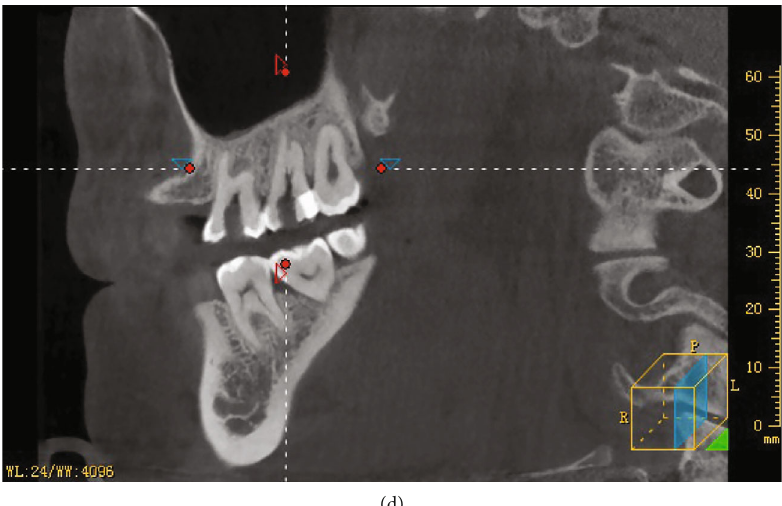
Figure 3: Cone-beam computed tomography images. Horizontal sections at (a) ori fi ce level, (b) midroot level, (c) apical level, and (d) sagittal view reveal a type 1 – 3 canal.